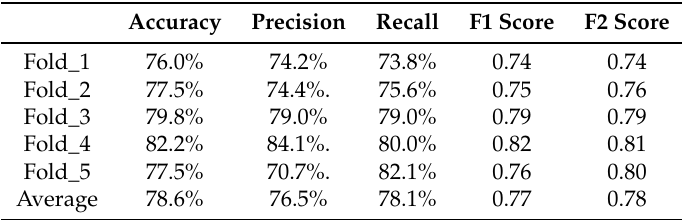
Table 1. Five-fold cross-validation results.